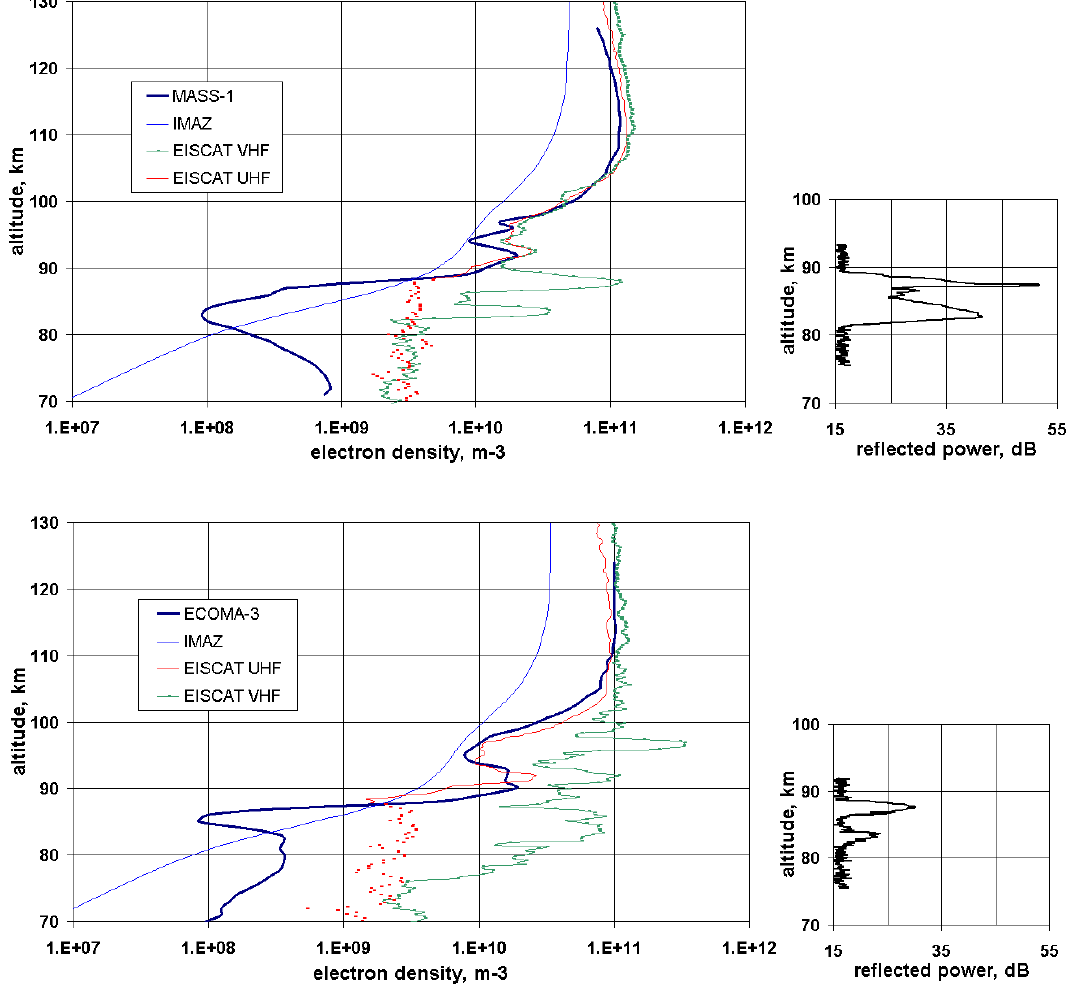
Figure 2. Electron densities of MASS-1 and ECOMA-3 compared to the EISCAT results and an empirical model (smooth line). The panels on the right show reflected power measured by the ALWIN MST radar at the rocket range using the beam 7 ◦ off vertical to the northwest, i.e. largely coincident with the rocket trajectory. Clearly the features below 90km of EISCAT VHF during MASS-1 are due to PMSE (cf. the right panel), whereas during ECOMA-3 below 100 km they are simply useless.